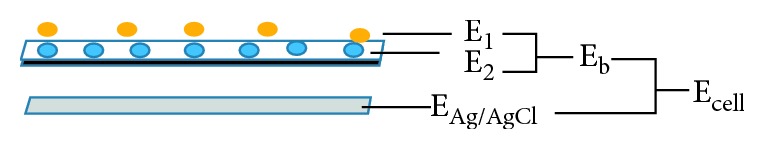
Illustrated measurement principle of phenol using the nata de coco membrane ( = phenol in membrane,  = phenol in the analyte, E1 = Eanalyte, E2 = Emembrane, Esel= Ecell, and Eb = the potential difference between membrane boundaries and analytes).